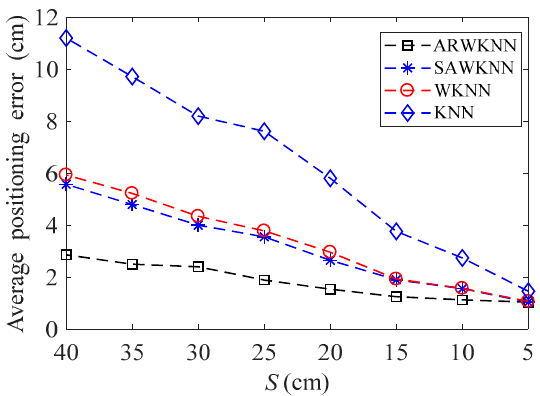
Figure 12. In 2-D, the impact of S on the average positioning error with K max = 4.